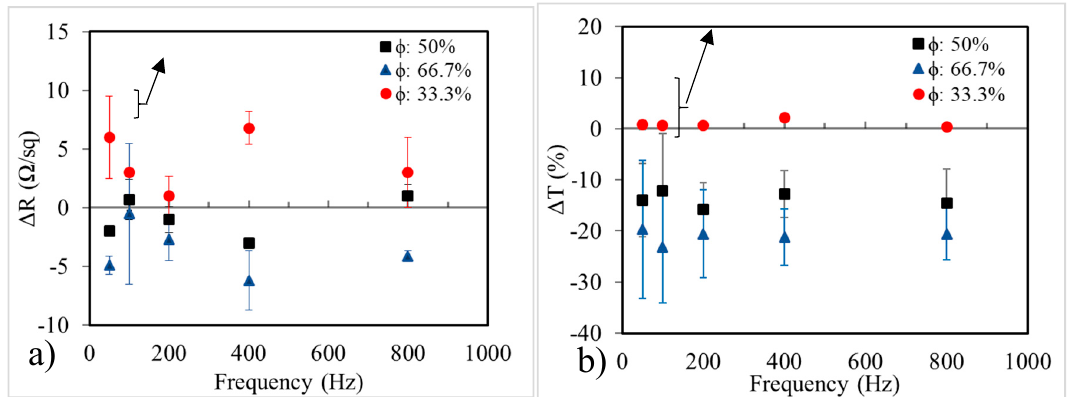
Figure 7. XRD patterns showing the influence of duty cycle ( ϕ ) on the crystal orientation of nickel deposits for an average applied voltage of 1.25 V.